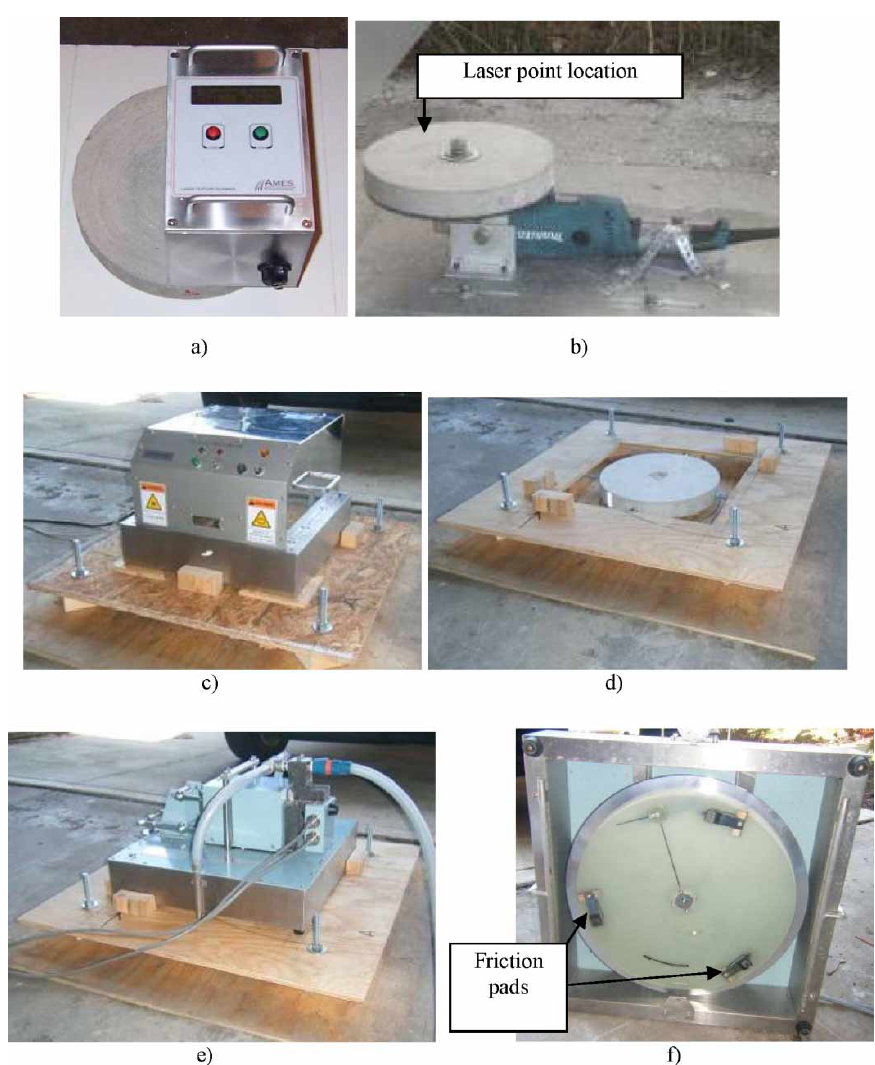
Fig. 1. Testing apparatus: (a) laser texture scanner; (b) apparatus for Dynatest laser scanner and sample; (c) CT meter on test rig; (d) adjustable test rig for CT meter and DFT; (e) DFT on test rig; (f) bottom of DFT showing friction